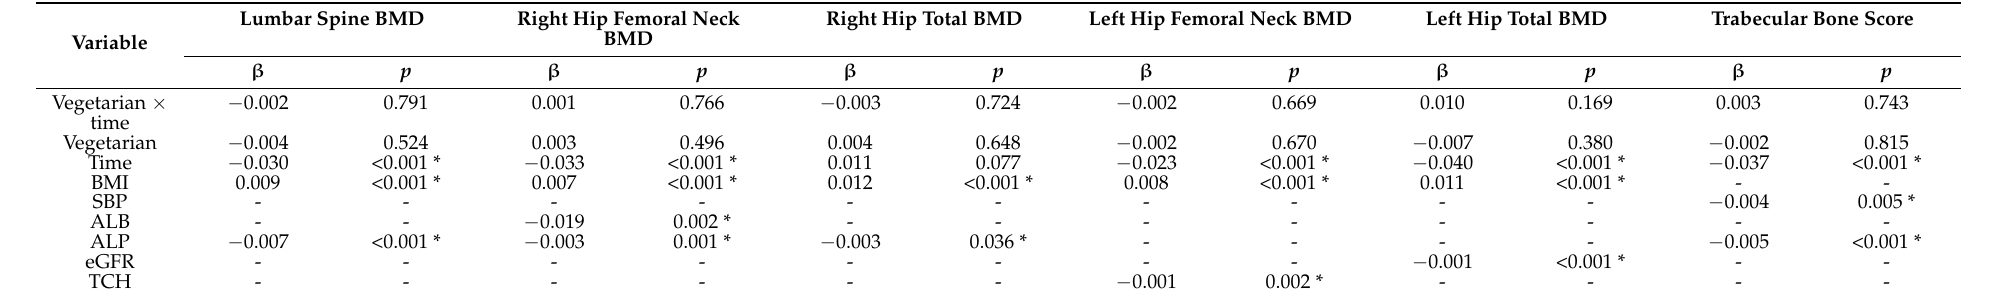
Table 3. Results of generalized estimating equations for the effects of a vegetarian dietary habit on the change in BMD and trabecular bone score over time in female patients aged 56–64 years ( n =